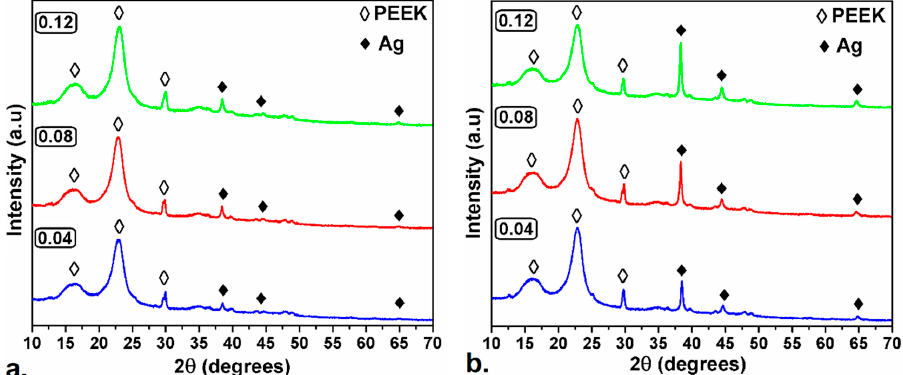
Figure 1. X-ray diffraction (XRD) patterns of polyetheretherketone (PEEK)/Ag0.04, PEEK/Ag0.08 and PEEK/Ag0.12 samples (a) with one coating layer and (b) with two coating layers.